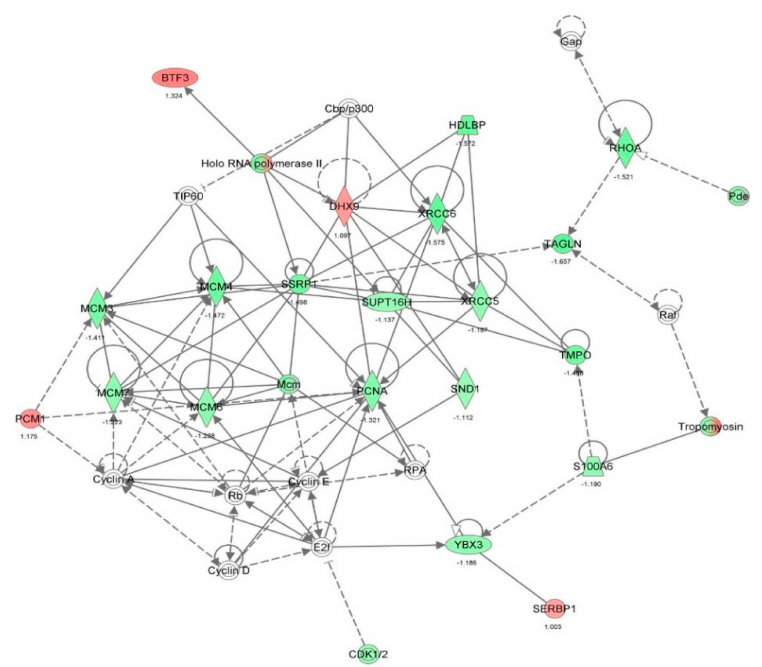
Figure 18. Vancomycin regulated DNA replication, recombination, and repair, cell morphology, and cellular function and maintenance. Red indicates an up-regulation; green indicates a down-regulation. The intensity of green and red colors indicates the degree of down- or up-regulation. Solid arrow indicates direct interaction and dashed arrow indicates indirect interaction.